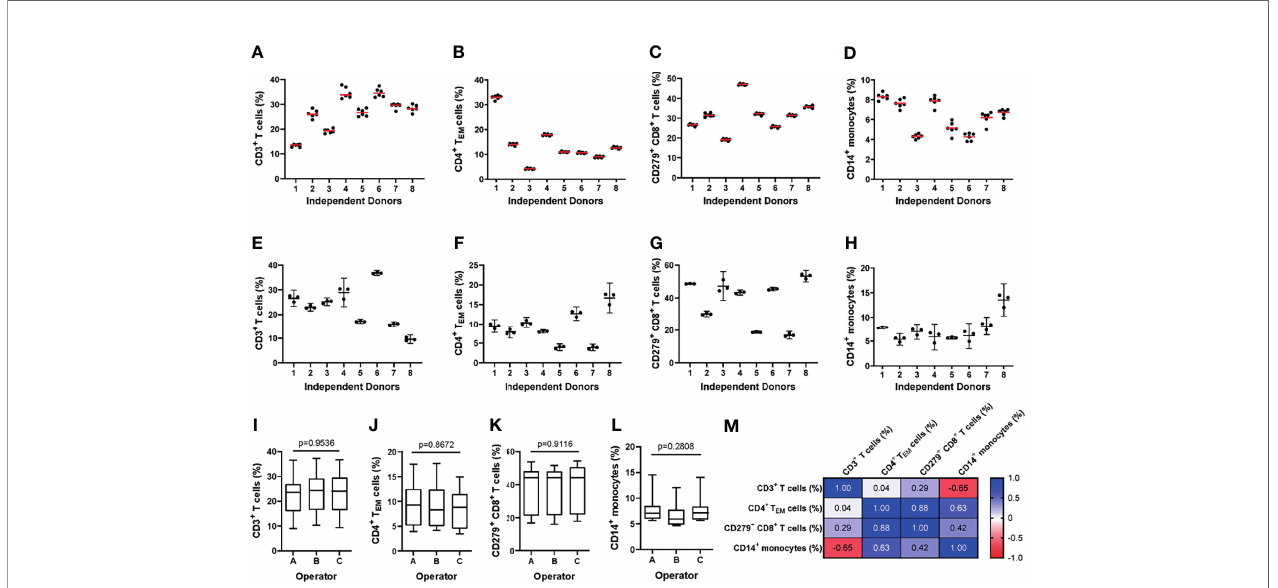
FIGURE 3 | Evaluating the intra- and inter-assay precision of the MoT test. (A – D) For evaluation of intra-assay precision, 6 replicates from fresh whole blood EDTA samples from n = 8 healthy donors were stained using the MoT test. (E – I) For evaluation of inter-assay precision, fresh whole EDTA blood from n = 8 healthy donors was stained in parallel by three different operators. Frequencies of CD3 + T cells (A, E) , CD4 + T EM cells (B, F) , CD279 + CD8 + T cells (C, G) and CD14 + monocytes (D, H) were determined ( A – D : replicates are represented by dots, mean is displayed as red line; (E – H) : operator-dependent results are displayed as scatter dot plot with line at mean and 95% CI). (I – L) Reporter frequencies of inter-assay precision analyses (K.W. test). (M) Correlations (Pearson r) between reporters measured by the MoT